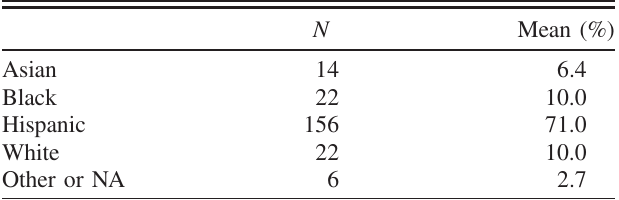
TABLE III. Students ’ ethnicity distribution. For each group, the first column gives the overall number of students enrolled and the second column gives the average percentage of students between the three